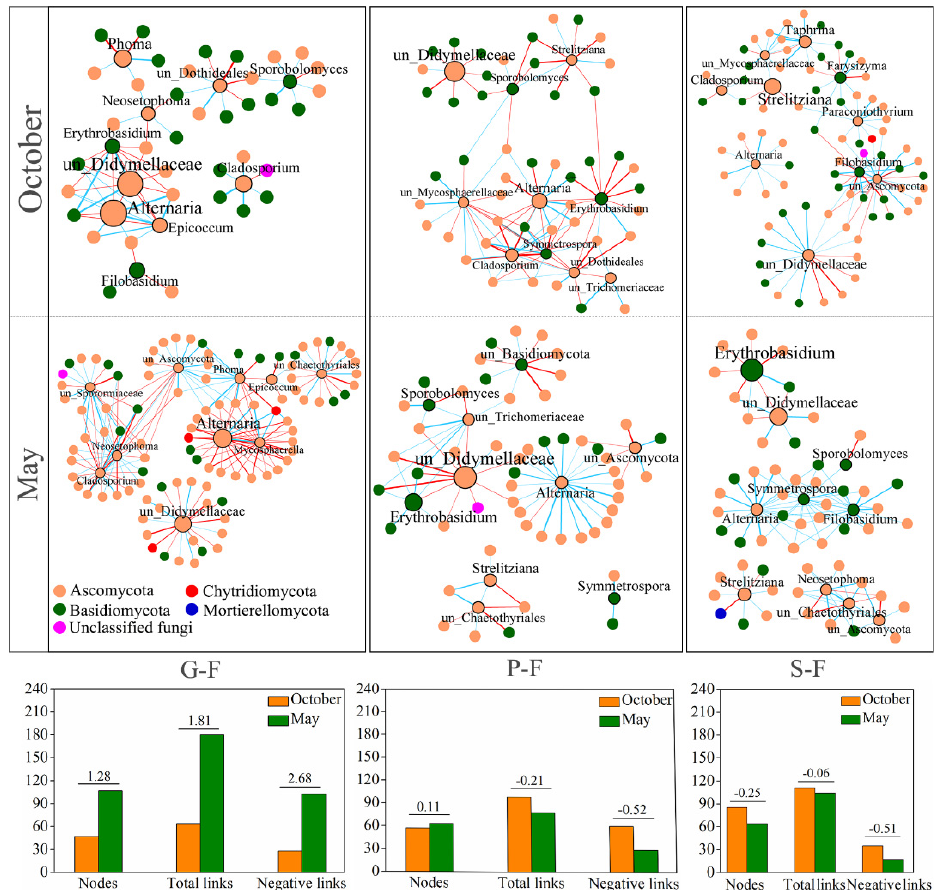
Figure 6. Fungal ITS region genera-based correlation network for G. biloba , P. bungeana and S. chinensis at forest in October and May. A node represents a genus. A connection stands for a strong (Spearman’s q > 0.75 or q < − 0.75) and significant ( p < 0.01) correlation. Edge widths are scaled according to their weights and edge colors indicate a positive (blue) or negative (red) correlation for the nodes they connect. The numbers on columns indicate the ratio of increase in May compared to October.